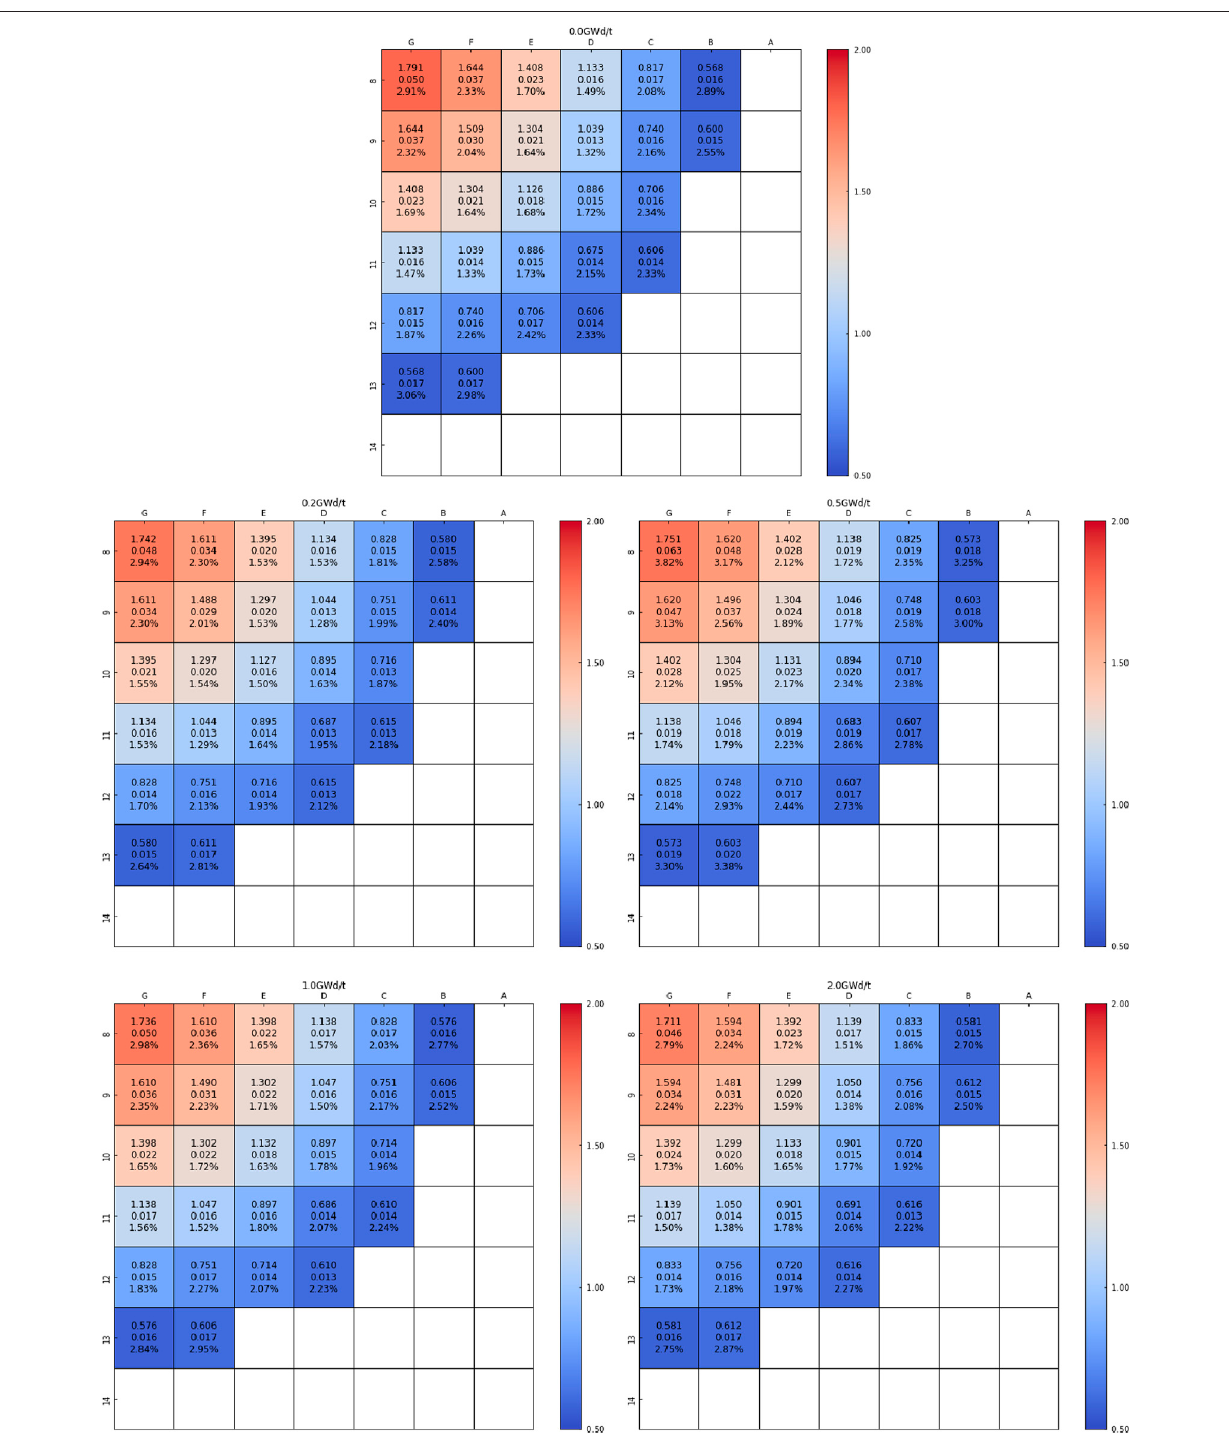
Frontiers in Energy Research |